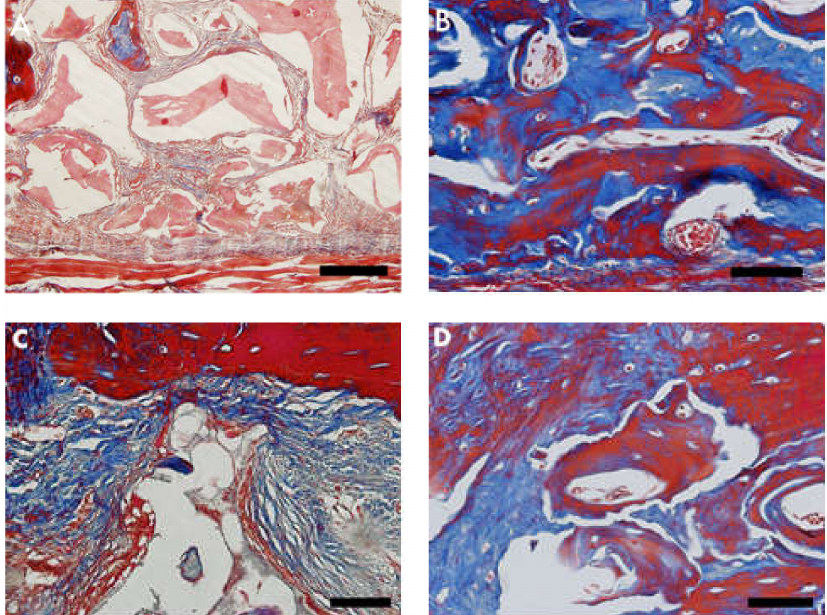
Figure 3. Photomicrographs of Masson’s trichrome stained slides. Bluish color indicates collagen fibrils in bone matrix. ( A,C ) Group 1 (bone xenograft), ( B,D ) Group 2 (nano-hydroxyapatite / beta-tricalcium phosphate composite ). Scale bar = 100 µ m, 400 × magnification.